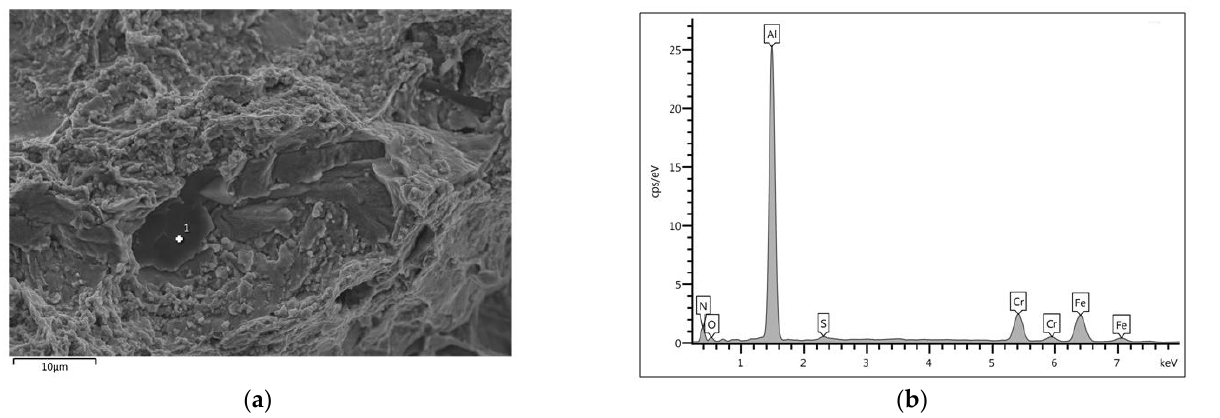
Figure 15. SEM image of cast steel fracture after tensile test and prior isothermal holding at 750  C for 1 h ( a ) — with X-ray spectrum of the AlN area (Point 1 on microstructure) ( b